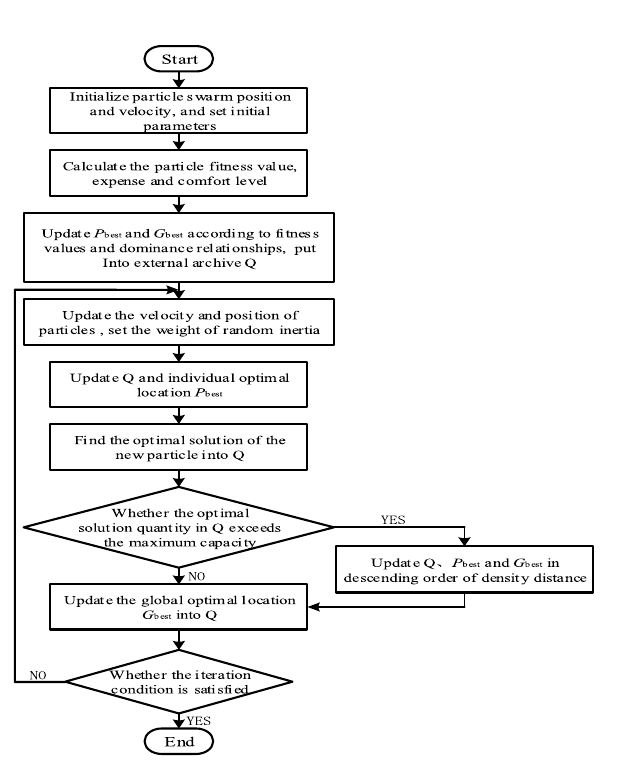
Figure 2. Flowchart of multi-objective particle swarm